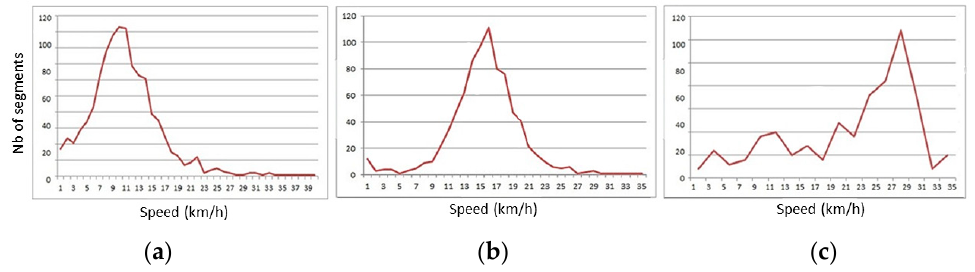
Figure 5. Examples of speed distributions: ( a ) Skewed left and high kurtosis (K); ( b ) normal and high K; ( c ) skewed right and low K. One figure represents one single trace.